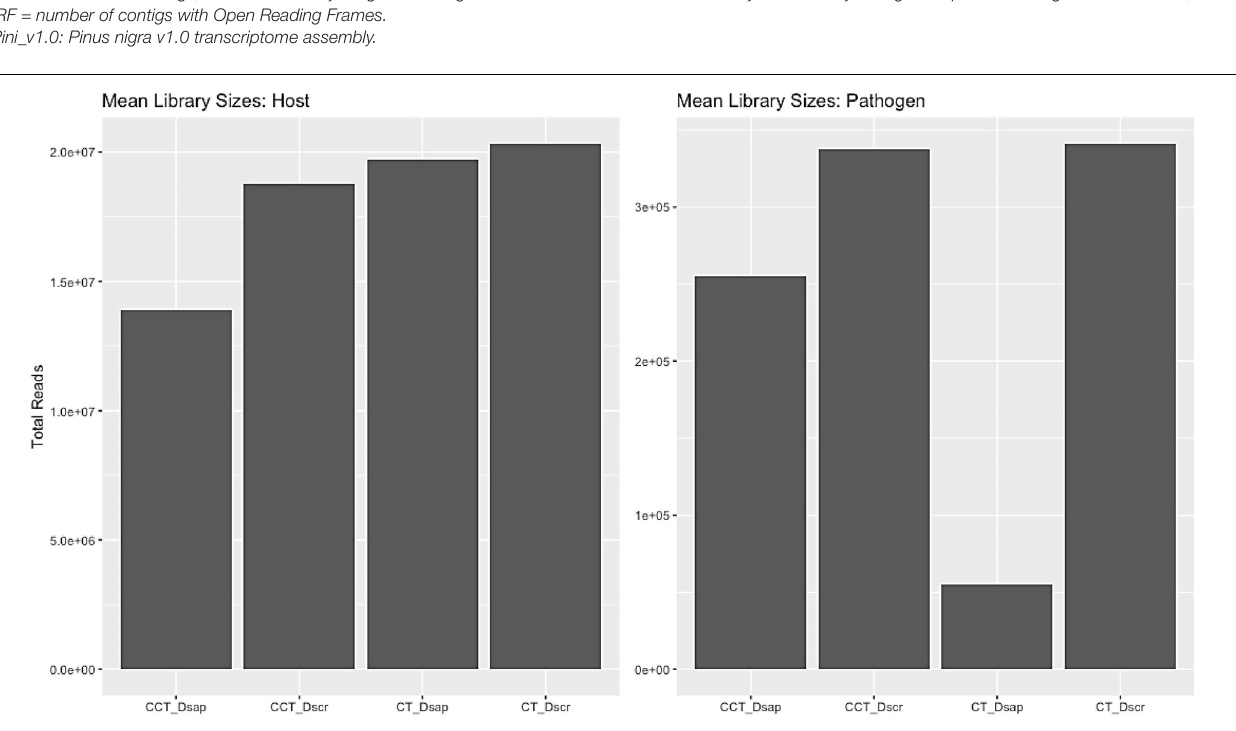
FIGURE 3 | Average library sizes retrieved for host and pathogen for all treatment types. Host average library size range: 15–20 million reads; pathogen average library size range: 0.004–0.3 million reads. CT, control treatment; CCT, climate change treatment; Dsap, inoculated with Diplodia sapinea ; Dscr, inoculated with D. scrobiculata